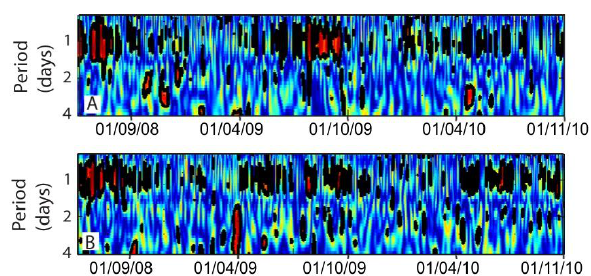
Fig. 9. Wavelet coherence analysis (WCA) output showing tempo- ral correlation between GPP and the temperature independent soil CO 2 efflux components: R r (A) and R m (B) for the enlarged 1-day to 4-day periods as in Fig. 8. See previous figures for